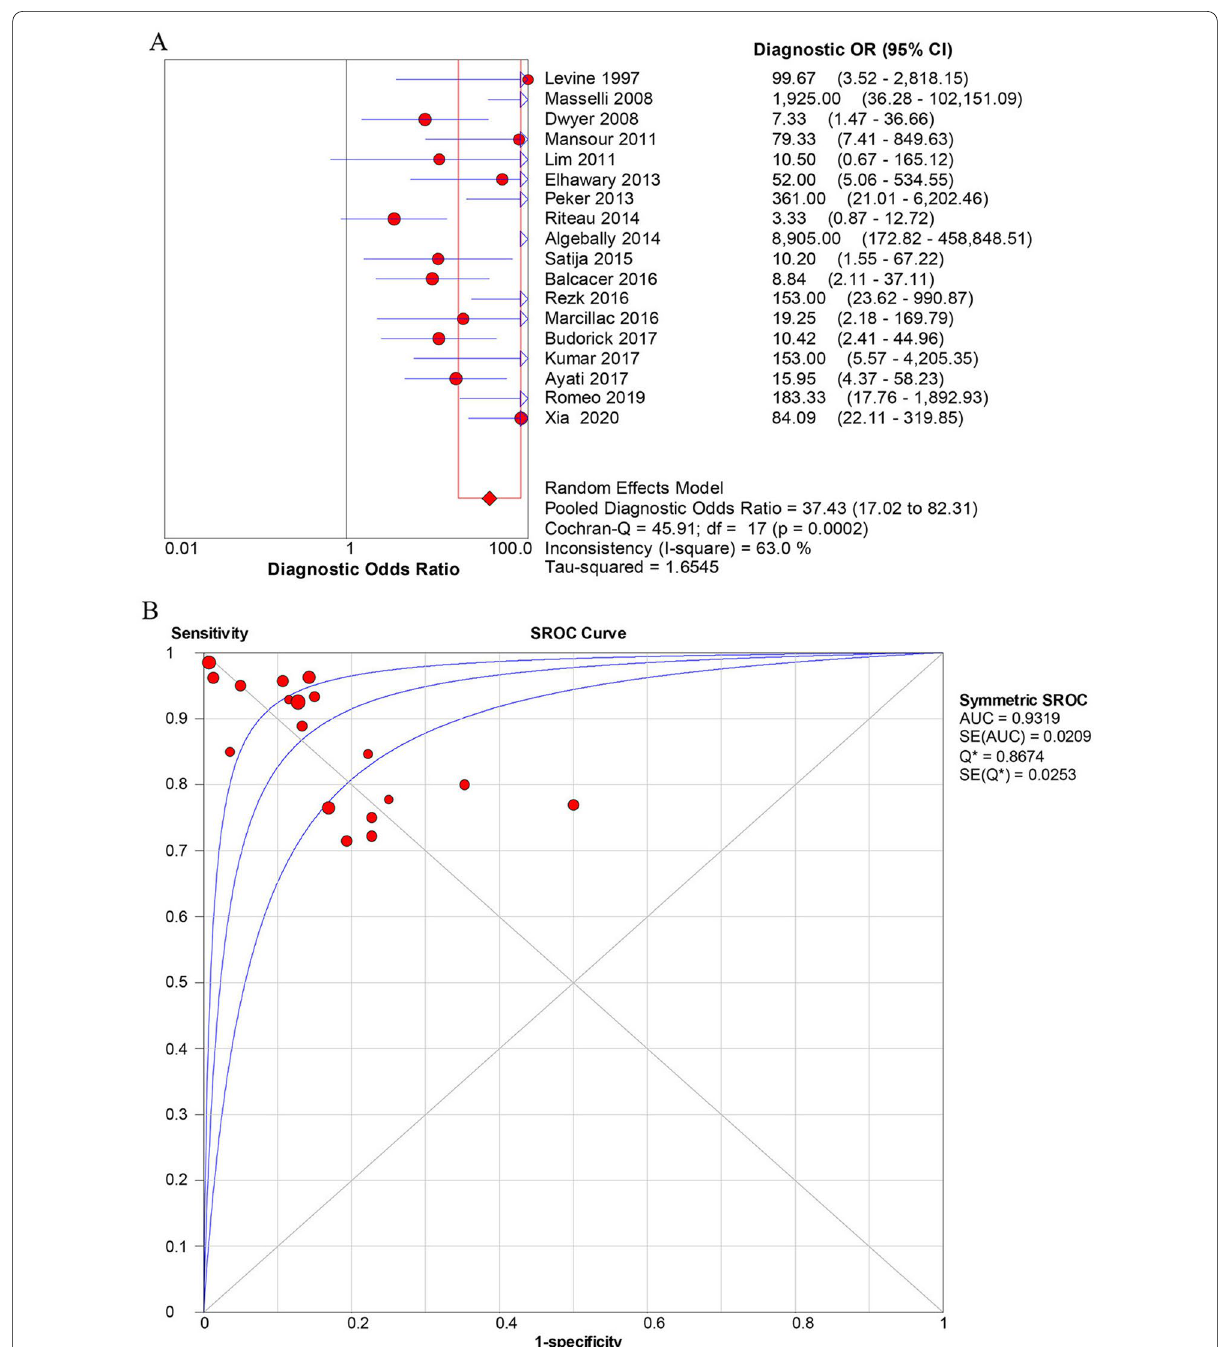
Fig. 6 The diagnostic performance of magnetic resonance imaging (MRI) for the prenatal identification of placenta accrete spectrum disorder (PAS) based on the A forest plots of overall diagnostic odds ratio (DOR) and B summary receiver operating characteristic (SROC) curve. The weight of each study is reflected by the size of data points. AUC, area under the curve; SE, standard